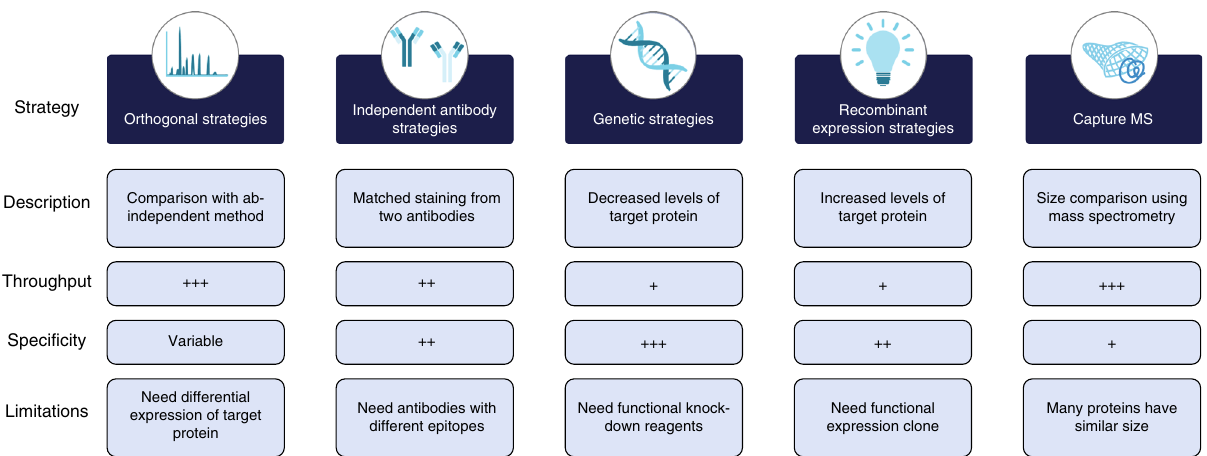
Fig. 1 Advantages and disadvantages of the fi ve strategies used for enhanced Western blot antibody validation. Throughput is a relative estimate of the possibility to use the method for high-throughput settings and speci fi city is the estimate of how reliable the validation results are to determine the speci fi city of the antibody. Low: + , Medium: ++ , High: